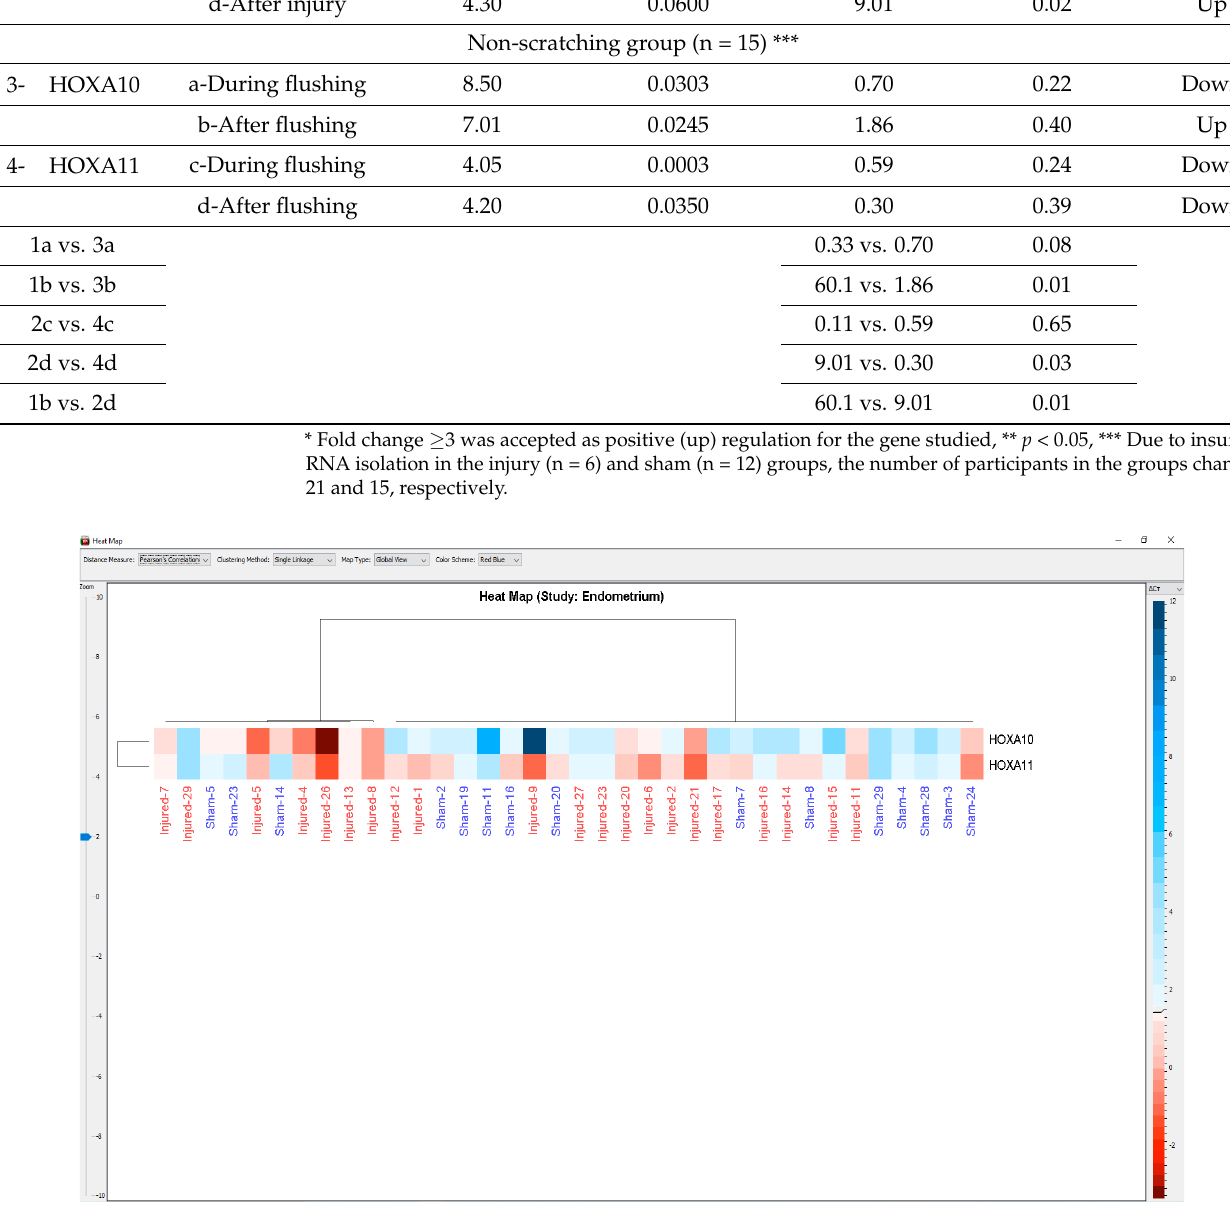
Figure 2. The heatmap plot shows the differences in expression levels of the HOXA10 and HOXA11 genes for each sample. Distance was measured according to Pearson Correlation and Single Linkage clustering method was applied during analysis. All p values were adjusted according to the Benjamin–Hochberg False Discovery Rate.